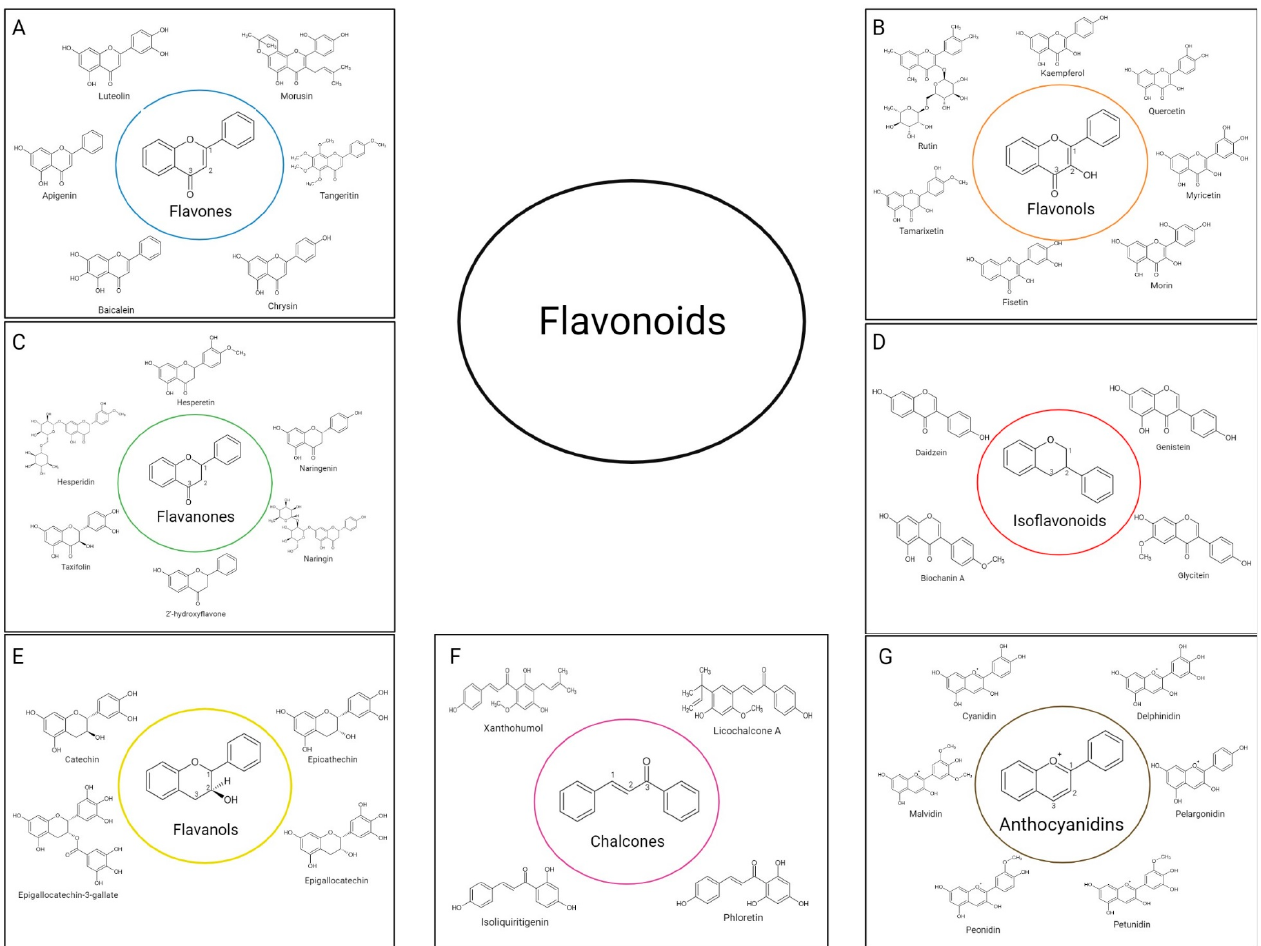
Figure 5. Classification of flavonoids: ( A ) flavones, ( B ) flavonols, ( C ) flavanones, ( D ) isoflavonoids, ( E ) flavanols, ( F ) chalcones, ( G ) anthocyanidins.